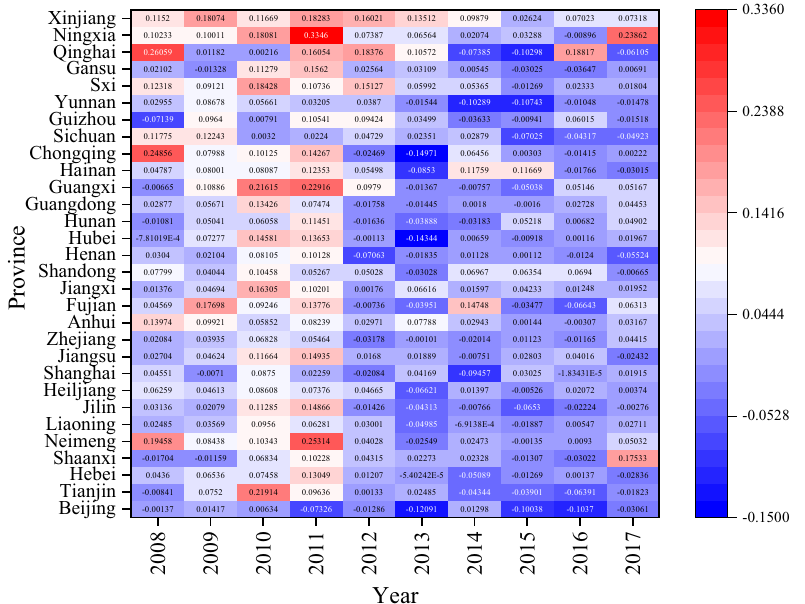
Figure 2. Growth rate of CO 2 emissions in 30 provinces in China from 2008 to 2017. Source : Origin 2021 https:// www. origi nlab. com/